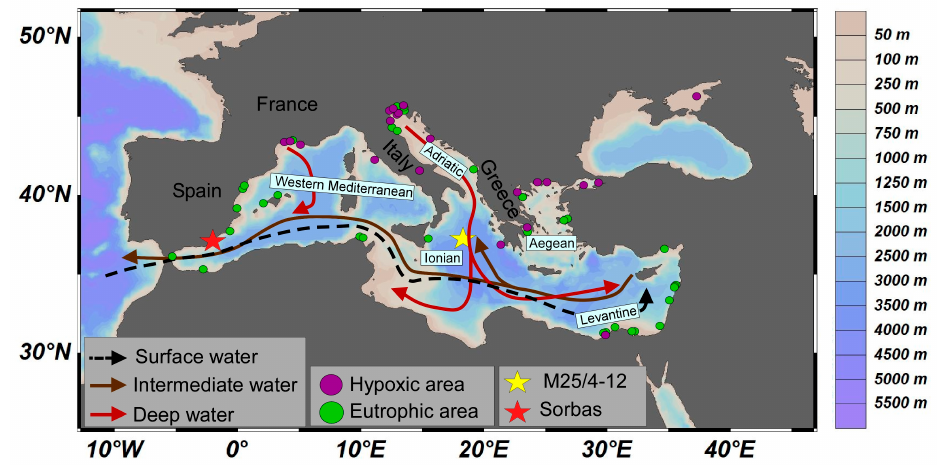
Figure 1. Map of the studied area. Yellow star indicates the M25/4-12 core location; red star indicates the Sorbas Basin location. Arrows indicate the major currents and their depth in the water column. Purple and green circles identify the location of hypoxic and eutrophic areas recorded from 1960 to 2010 in the coastal zones of the Mediterranean Sea (modified from UNEP-MAP [22,24]). Map obtained using the Ocean Data View software [26], (https://odv.awi.de, accessed on 2 December 2022).